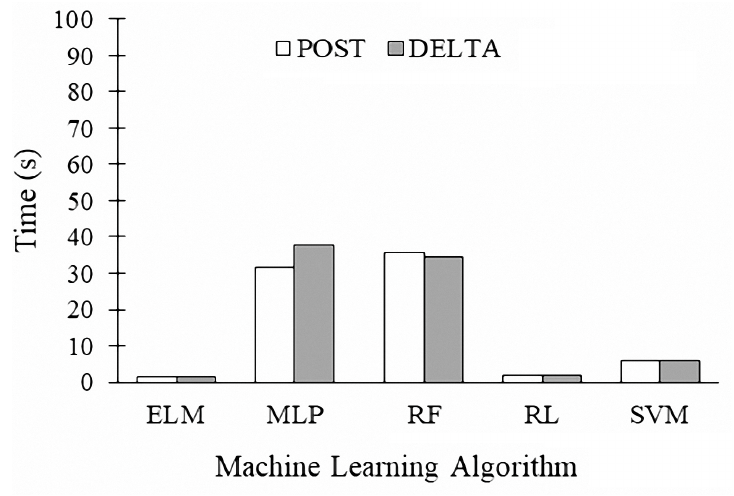
Figure 5. Training time for classification algorithms applied to POST and DELTA datasets.